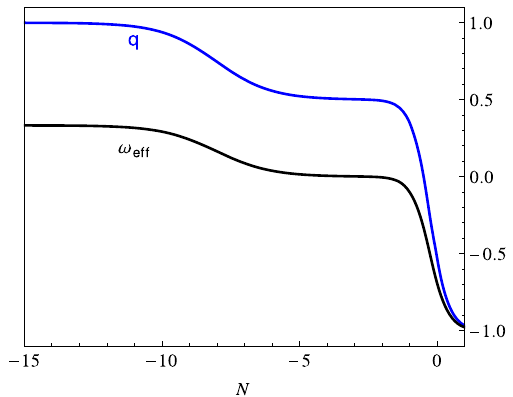
Fig. 6 Plot of deceleration parameter q and effective equation of state of the universe ω eff with the number of e-foldings N given by N = − ln ( 1 + z ) where z is the corresponding